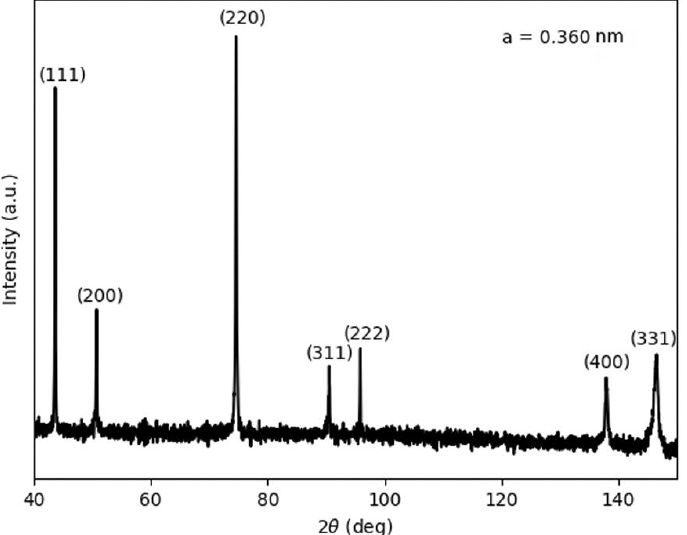
Figure 4. XRD pattern of as-received 316H material indicating its fully austenitic crystal structure,